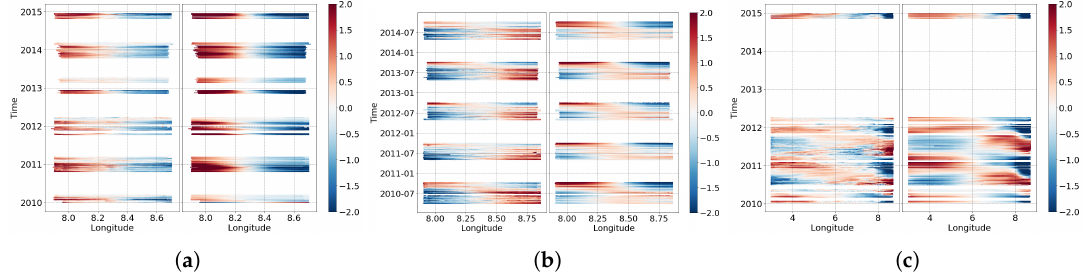
Figure 11. Temperature anomalies from the three ferry lines and corresponding model results. The observational data are on the left and the corresponding model results are on the right of each panel. Ferries: ( a ) Cuxhaven–Helgoland; ( b ) Büsum–Helgoland; and ( c )